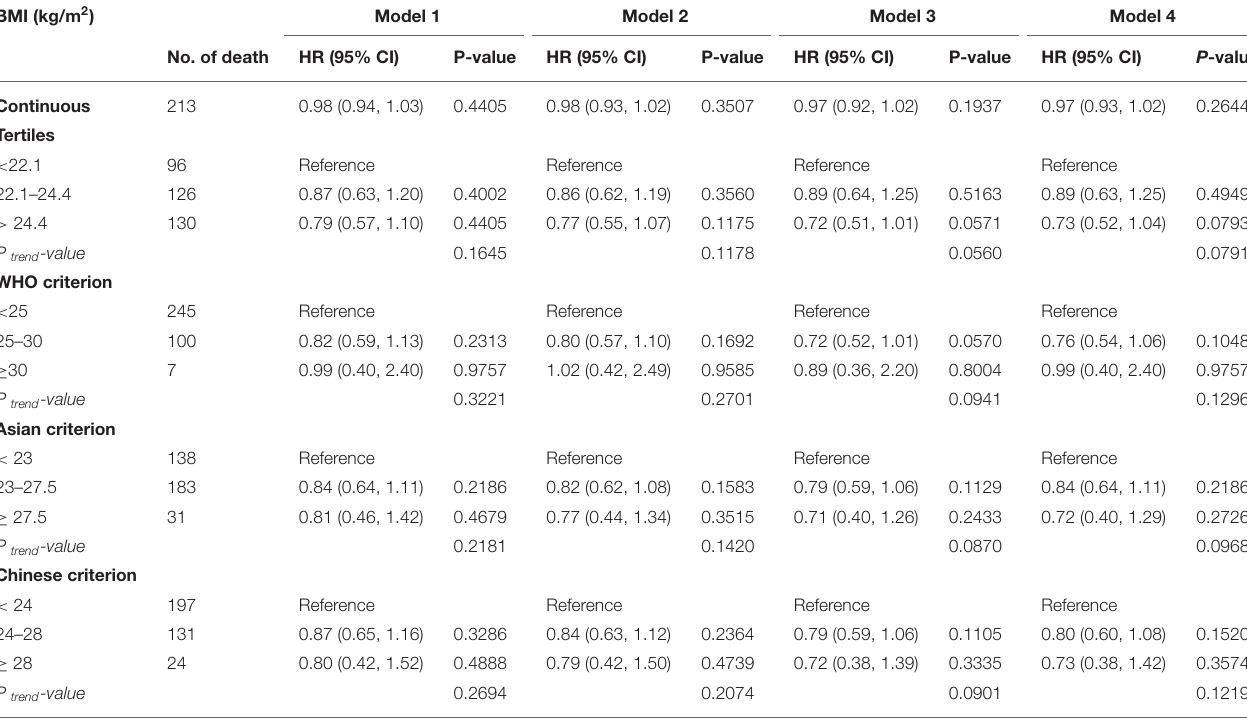
TABLE 2 | Association of BMI with all-cause mortality in different Cox proportional hazards